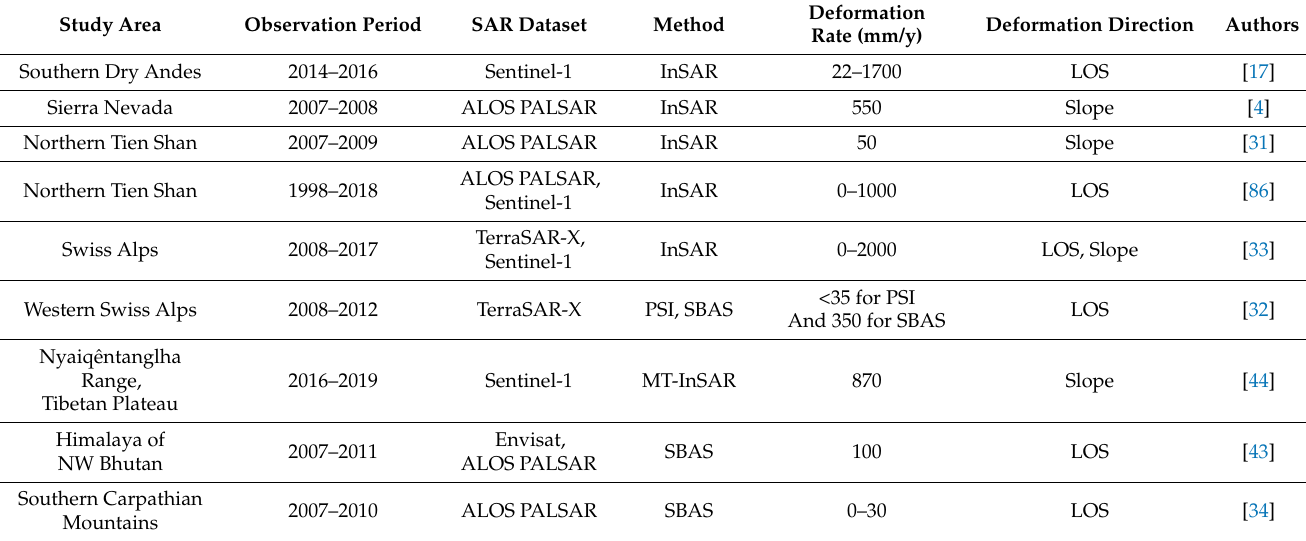
Table 3. Rock glacier deformation monitoring using InSAR and MT-InSAR methods in previous studies. Study